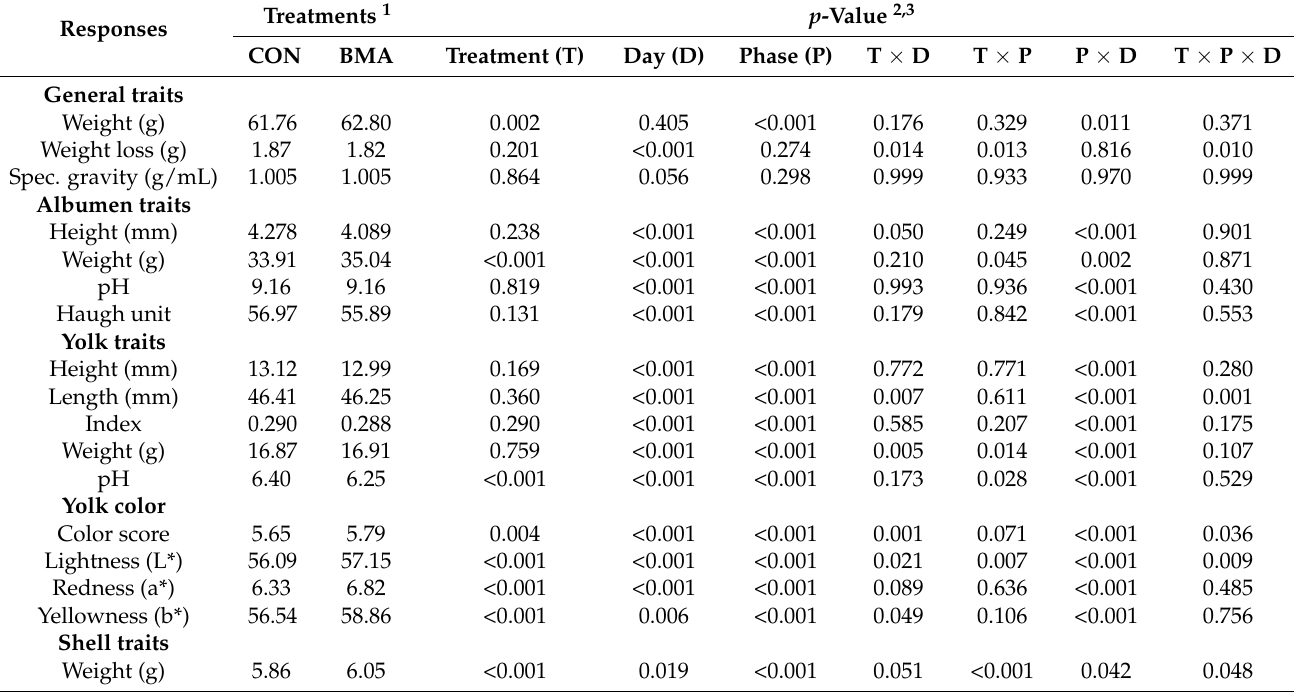
Table 1. Quality of eggs from laying hens fed diets supplemented with β